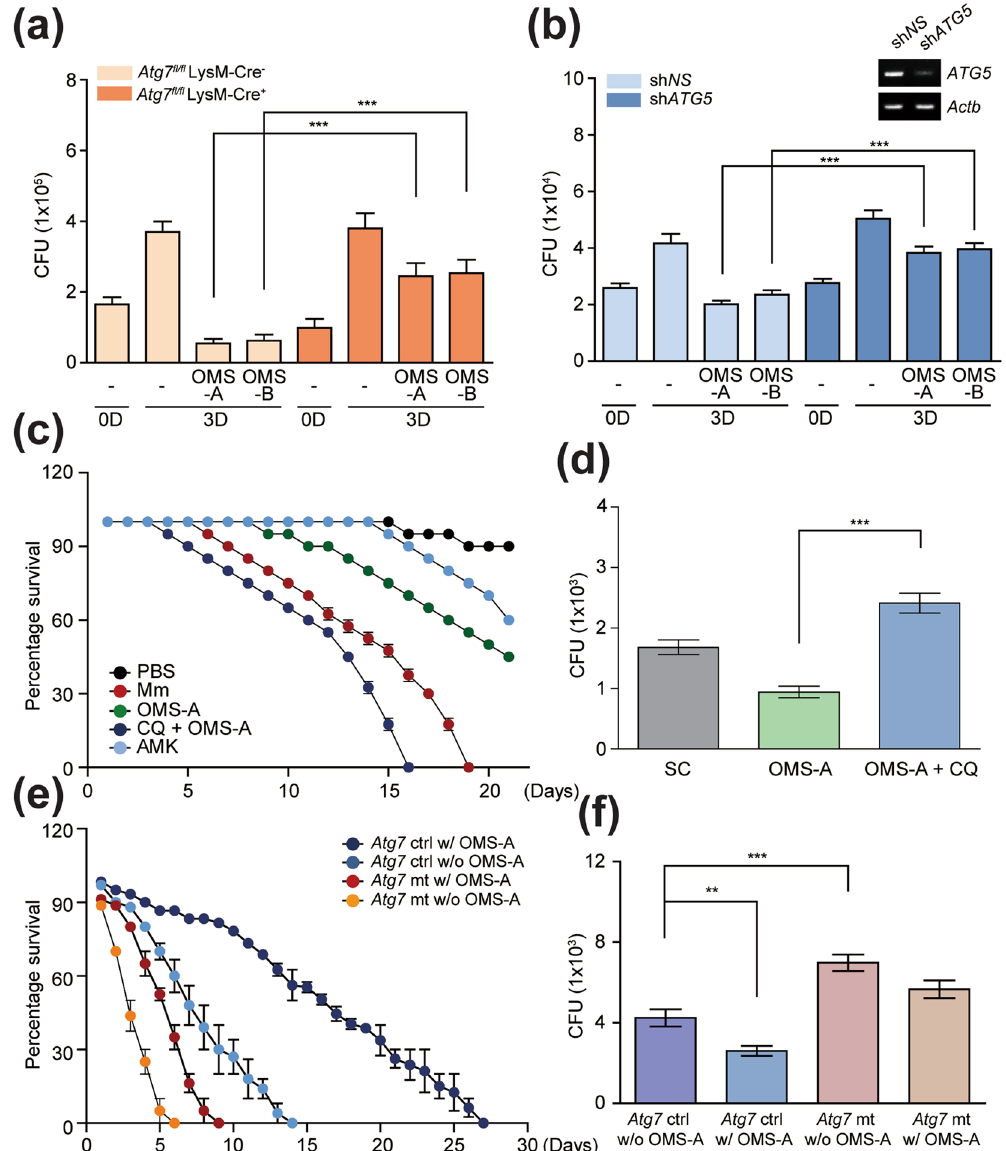
Figure 5. OMS-mediated autophagy activation is essentially required for antimicrobial responses against mycobacterial infection in vitro and in vivo . ( a ) Atg7 fl/fl LysM-Cre − and Atg7 fl/fl LysM-Cre + BMDMs were infected with Mtb (moi = 10) for 4 h and then treated with OMS-A (10 μ M) and OMS-B (10 μ M). ( b ) Human MDMs were transduced with non-specific shRNA (sh NS ) or ATG5 -specific shRNA (sh ATG5 )-expressing lentivirus for 48 h and then infected with Mtb and then treated with OMS-A and OMS-B. (inset) RT-PCR analysis of ATG5 mRNA expression of transduction efficiency. ( a and b ) CFU assay. The intracellular bacterial loads were determined at 3 days after infection. ( c and d ) W 1118 flies were infected with M. marium (CFU = 500), followed by incubation with or without OMS-A (10 μ M) in the presence or absence of chloroquine (1 μ M). Positive control group was treated with AMK (1 μ g/ml). ( e ) Live flies were counted at 24 h intervals (n = 40). The error bars indicate 95% confidence intervals. Log-rank analysis of the survival curves indicated that the susceptibility to M. marinum was significantly increased in the group of OMS-A with chloroquine, when compared with that of OMS-A only ( *** p < 0.001). ( f ) Each group (n = 20) of flies was harvested at 7 days, homogenized, and quantified by CFU assay. ( e and f ) Atg7 control and Atg7 mutant flies were infected with M. marium (CFU = 500), followed by incubation with or without OMS-A (10 μ M). ( e ) Flies were counted at 24 h intervals (n = 50). The error bars indicate 95% confidence intervals. Log-rank analysis of the survival curves showed that the survival rates of Atg7 control flies were significantly increased by OMS-A treatment ( *** p < 0.001), whereas these were not significant in Atg7 mutant flies with the same treatment. ( f ) Each group (n = 20) of flies was harvested at 3 days, homogenized, and quantified by CFU assay. All data represent the means ± SD of triplicates from each sample. ** p < 0.01, *** p < 0.001, compared with control conditions ( a , b , d , f ). SC, solvent control; AMK, amikacin; CQ,